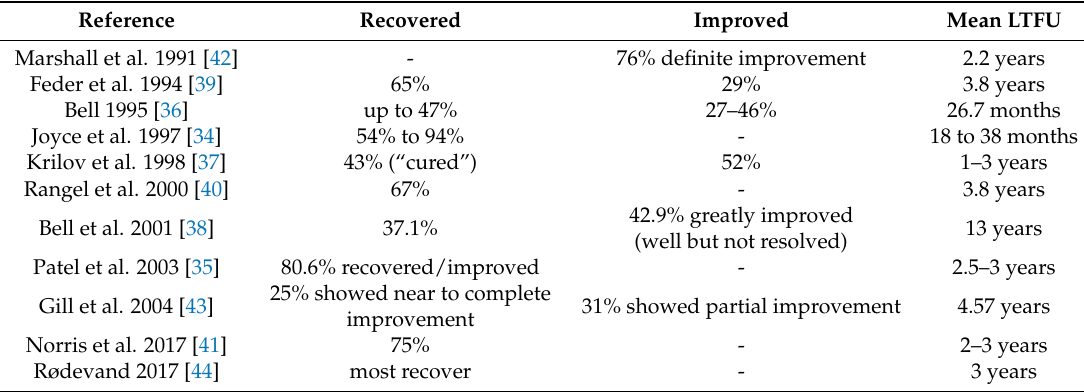
Proportions of spontaneously recovered and improved adolescents with Chronic Fatigue